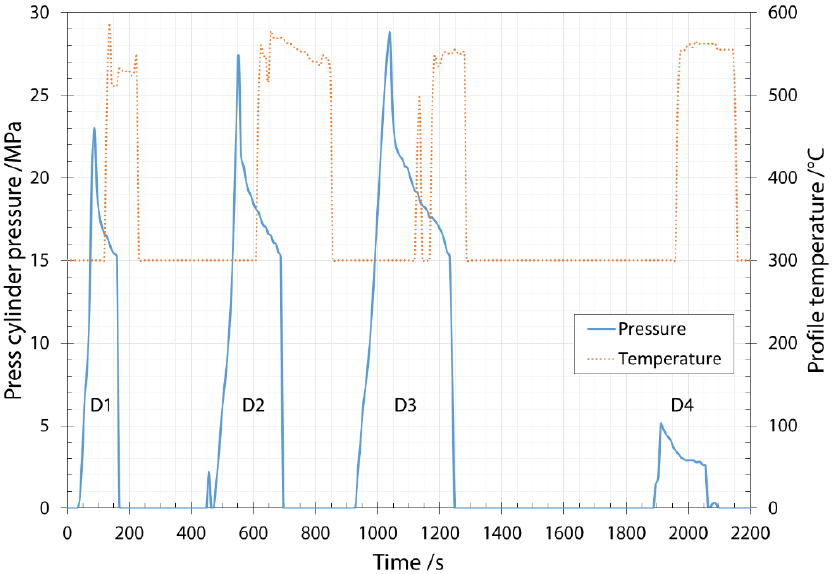
Figure 5. Main cylinder pressure and measured extruded profile temperature for all billets extruded with direct-extrusion press. Details of process parameters are listed in Table 2.